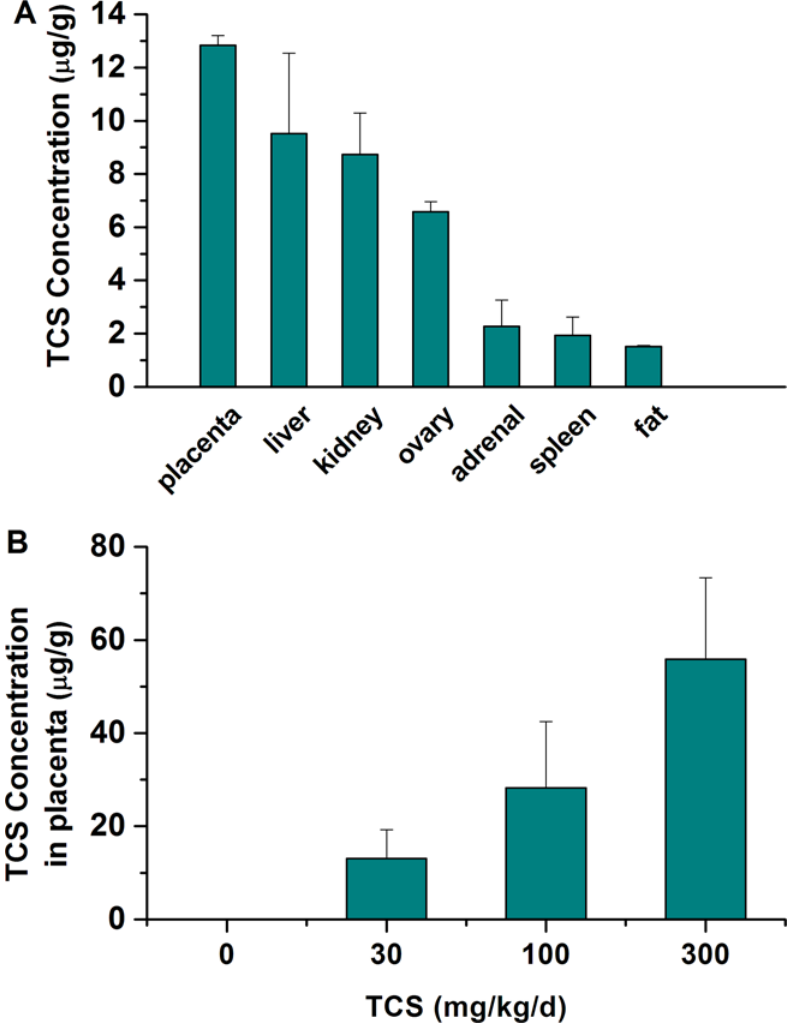
Fig 2. TCS concentrations in tissues. (A) Concentrations of TCS in different tissues from 30 mg/kg/d TCS- exposed pregnant rats (n = 6). (B) Concentrations of TCS in placenta from control and TCS-exposed pregnant rats. Bars represent the mean ± SD of six rats per